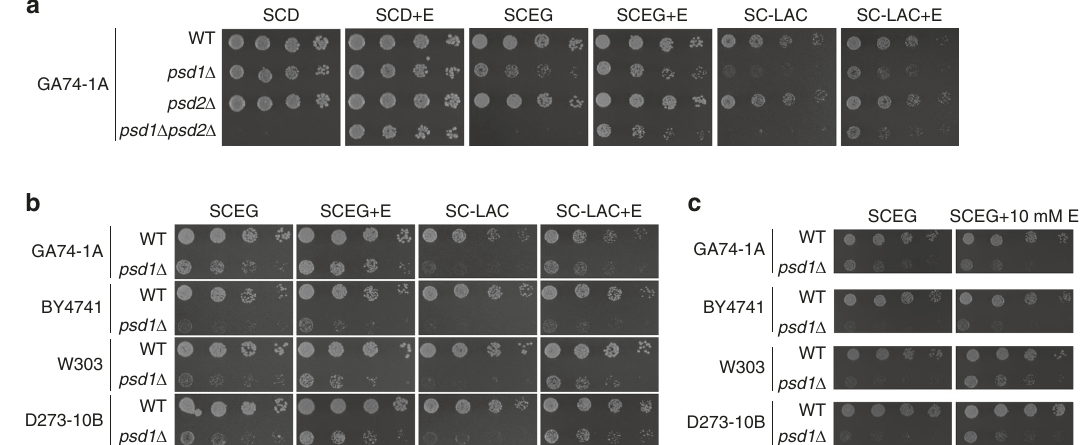
Fig. 1 Ethanolamine only partially rescues the respiratory growth defect of psd1 Δ yeast. The indicated strains were pre-cultured at 30 °C in YPD and spotted onto ( a , b ) synthetic complete dextrose (SCD), ethanol-glycerol (SCEG), or lactate medium with or without ( + / − ) 2 mM ethanolamine ( + E) or ( c ) SCEG with or without ( + / − ) 10 mM ethanolamine and incubated at 30 °C for 2 days (SCD + / − E) or 3 days (all the